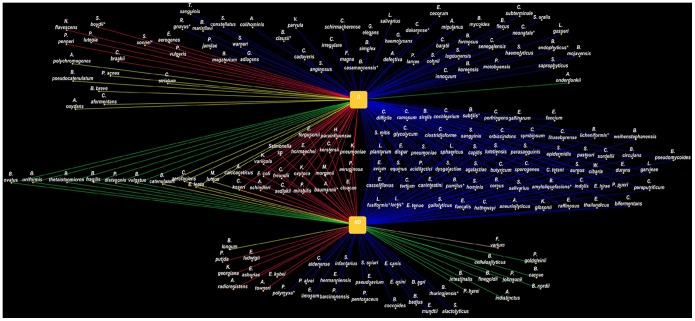
Isolates from individuals with diarrhea (D; top) and without diarrhea (ND; bottom).Each bacterial species corresponds to a node. The edge color represents the phylum (blue: Firmicutes; red: Proteobacteria; green: Bacteroidetes; yellow: Actinobacteria; pink: Fusobacteria). The common and specific bacteria detected from patients with diarrhea and those without are provided.